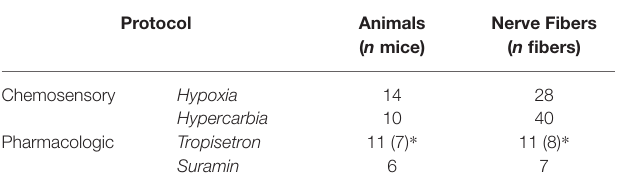
TABLE 1 | Summary of experiments, indicating number of animals, and individual afferent fibers